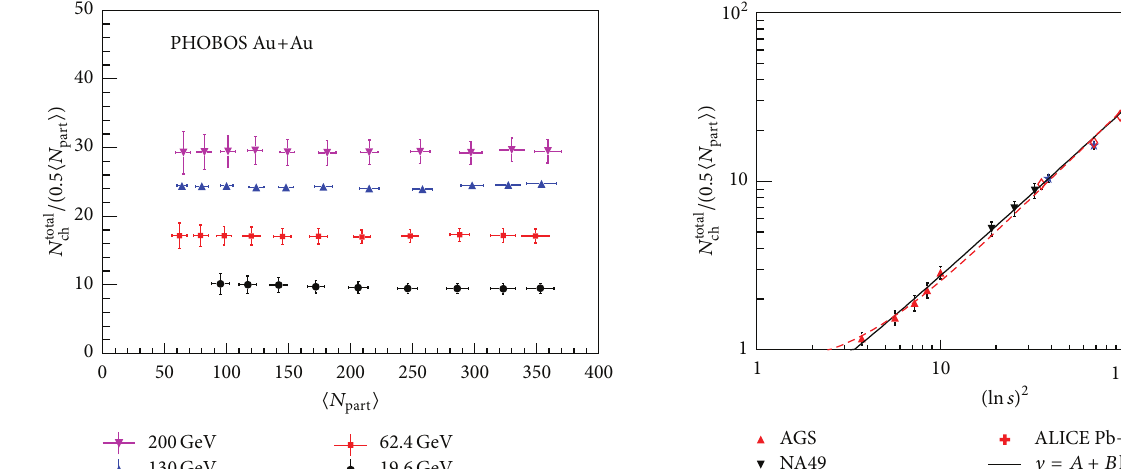
part Figure 22: Energy dependence of total charged particle multiplicity per participant pair for most central